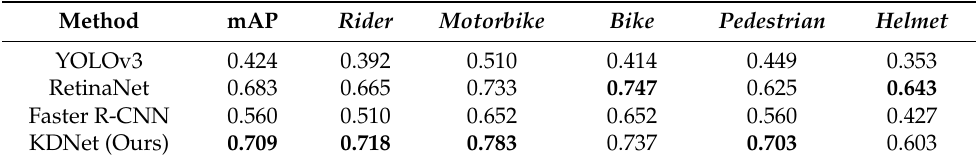
Table 2. The mAP and AP of the tested algorithms.